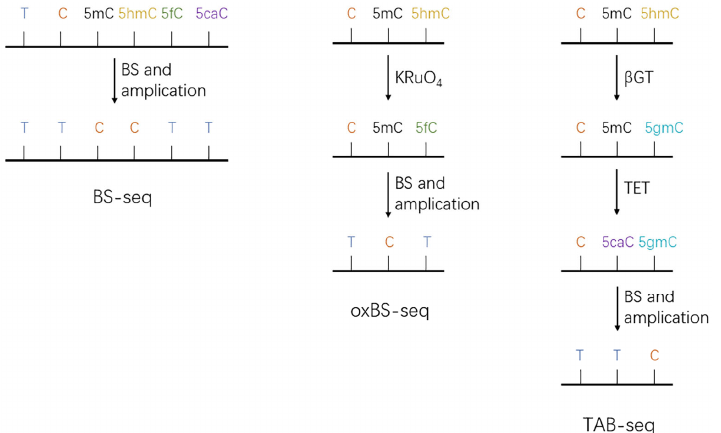
Figure 4. Schematic diagram of BS-seq, oxBS-seq, and TAB-seq. In BS-seq, C/5fC/5caC was read as T and 5mC/5hmC was read as C after sulfite treatment and sequencing. In oxBS-seq, 5hmC was oxidized by KRuO4 to 5fC, which was read as T after bisulfite and sequencing, while 5mC was read as C. In TAB-Seq, β -GT catalyzes the entry of glucose into 5hmC to produce 5gmC, which is se ‐ quenced as C, while 5mC is oxidized by excess TET to 5caC, which is sequenced as T.